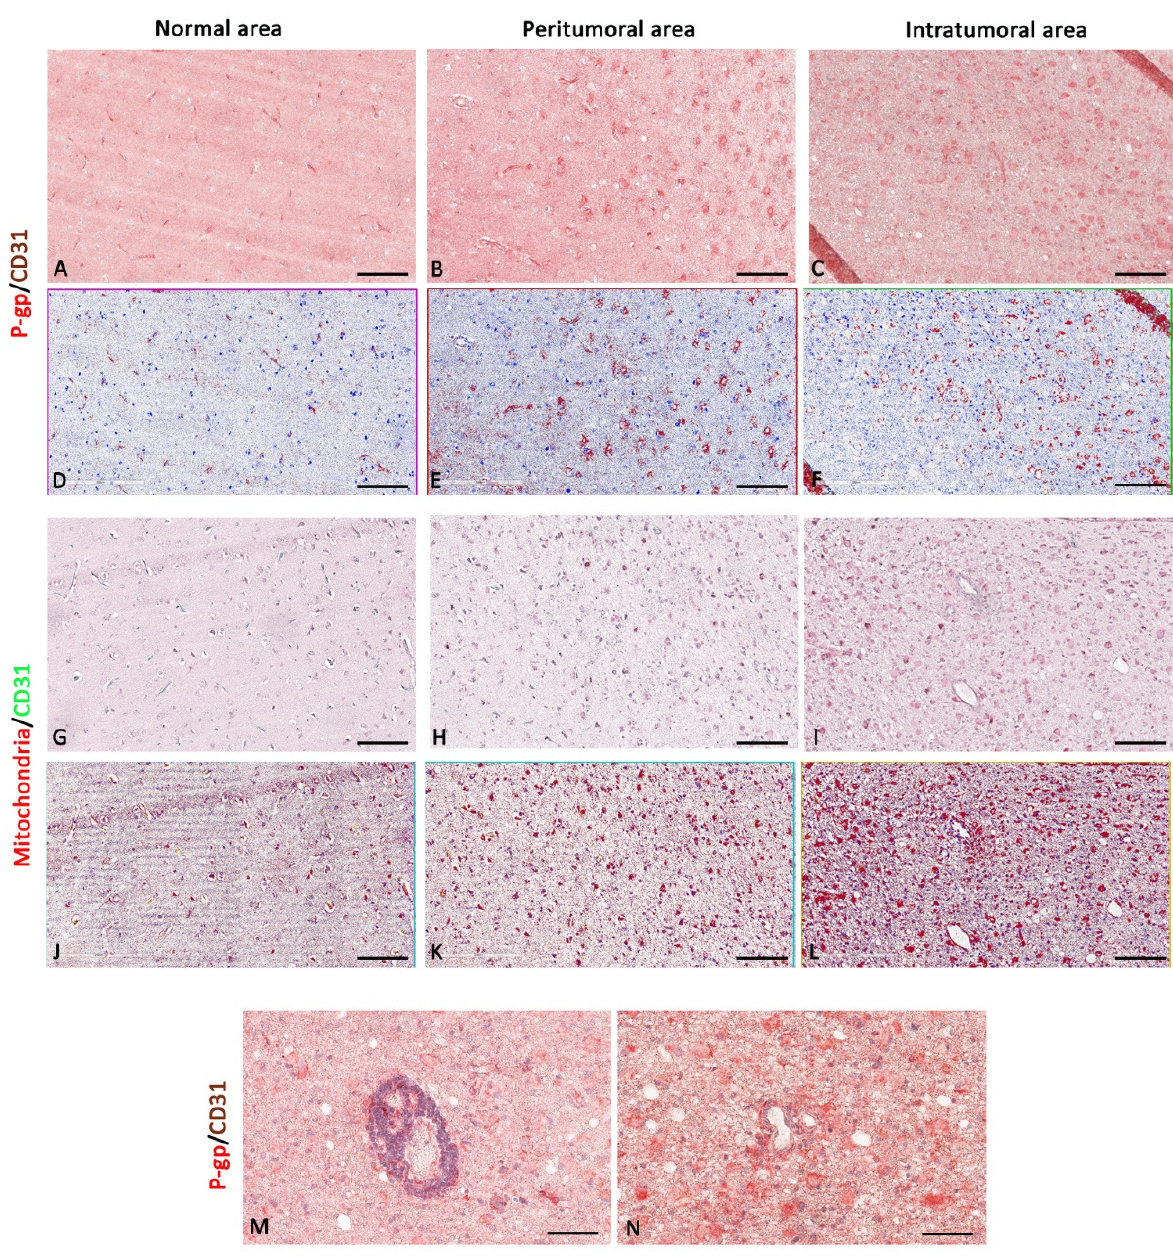
Figure 5. P-gp/CD31 and mitochondria/CD31 expression and colocalization in IDH-mutant astrocytoma. P-gp, mitochondria, and CD31 were evaluated by immunohistochemistry within the same spatial ROIs on IDH-mutant astrocytoma serial sections. P-gp ( A – F ) and mitochondria ( G – L ) expression progressively increase from normal to intra-tumoral areas. CD31 expression is not modified in the different areas ( A – L ). Intratumoral areas show perivascular satellitosis with lymphocytic infiltrate ( M ) or perivascular satellitosis solely ( N ). Scale bar: ( A – L ) 100 µ m; ( M , N ) 30 µ m. Below each micrograph is the relative markup image generated by the Aperio colocalization algorithm.